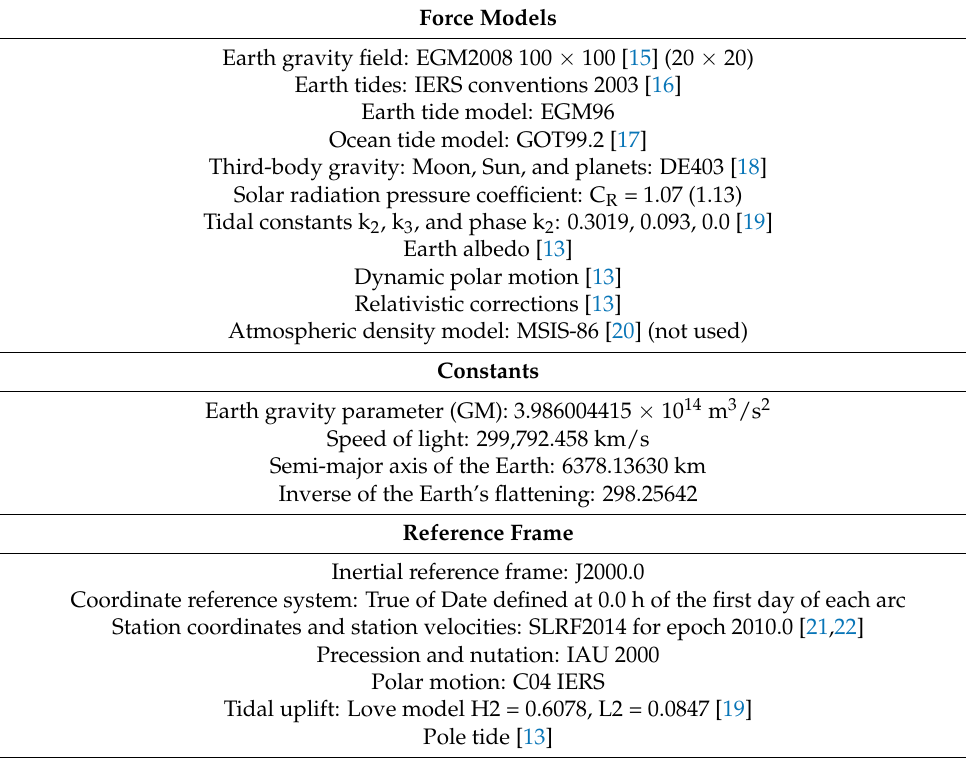
Table 2. Force models and parameters from the GEODYN-II orbital software in the LARES (LAGEOS data, if differing, are given in